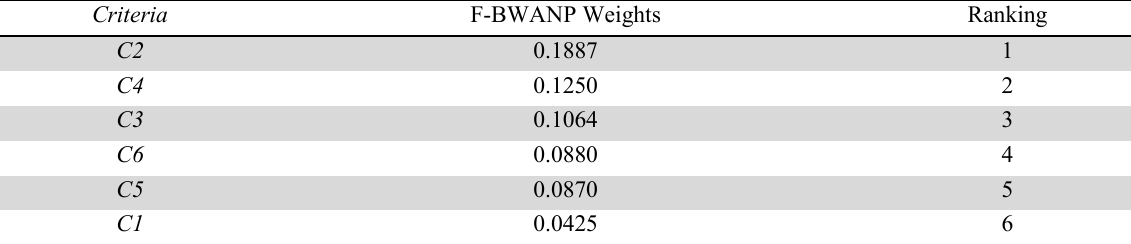
Ranking of criteria and alternatives